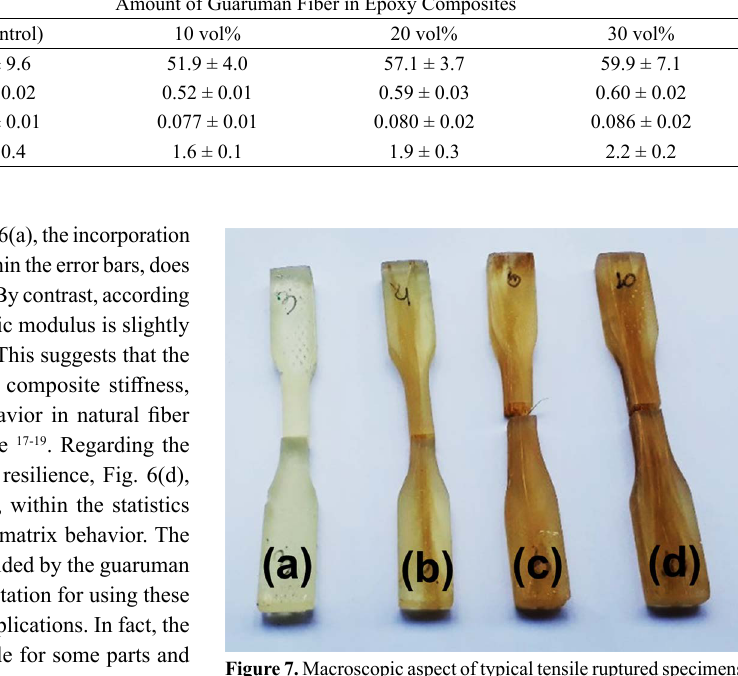
Table 2. Tensile properties of control epoxy and guaruman fiber composites Tensile Property